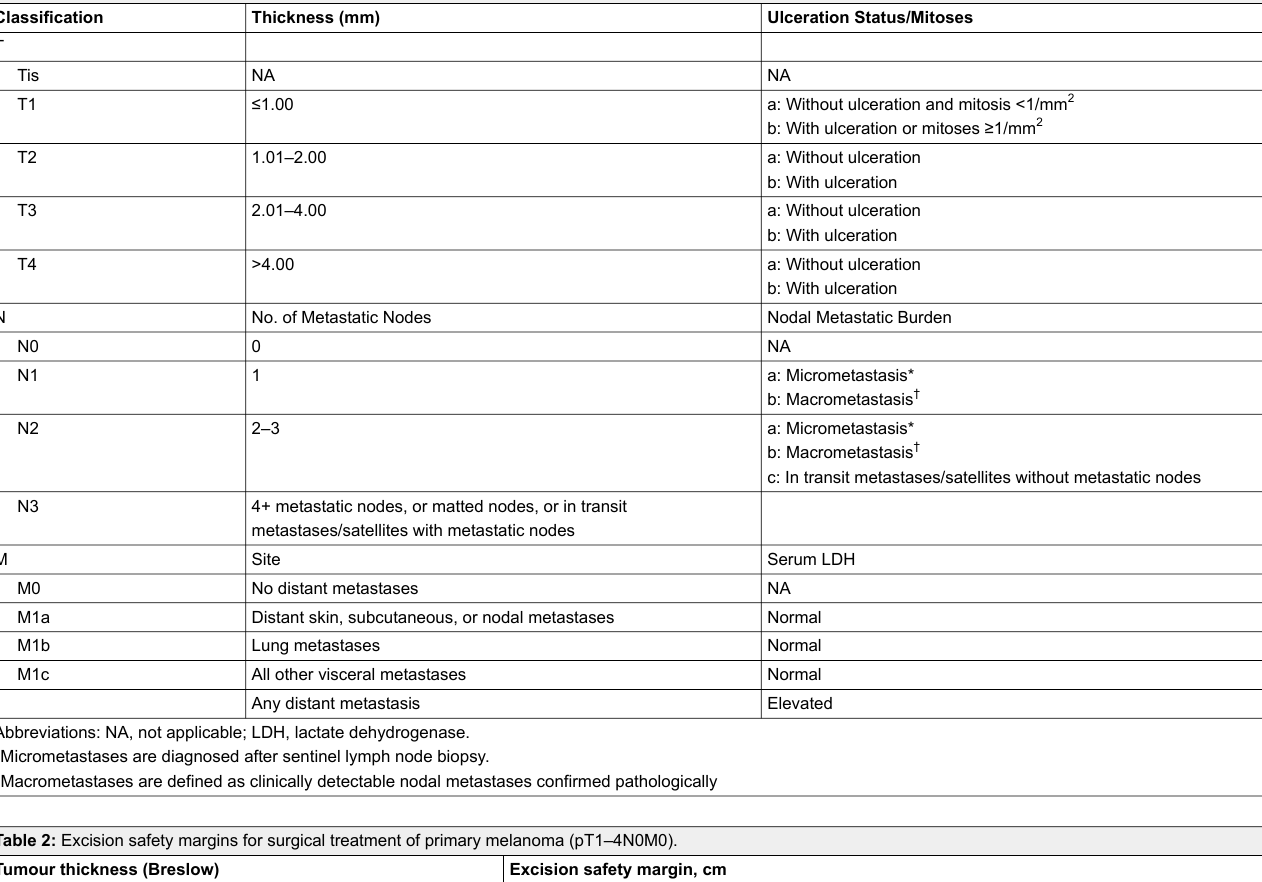
Table 1: The 2009 staging system for cutaneous melanoma according to the AJCC [5]. Classification